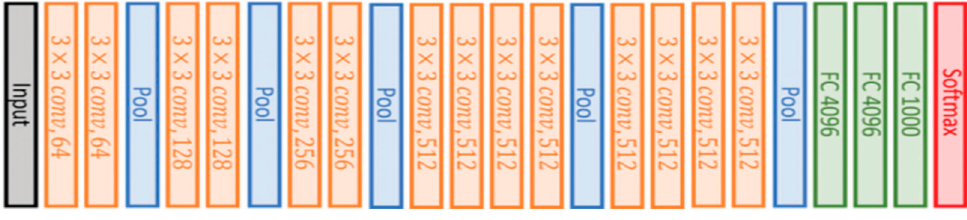
Figure 5. VGG19 original architecture.